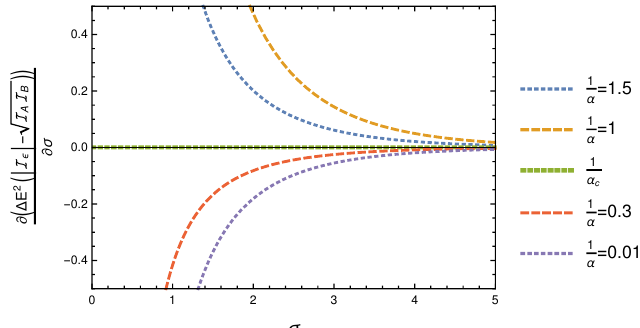
Figure 8 . In (1 + 1) dimensions the quantity ( ∂/∂σ ) anti-parallelly accelerating detectors with respect to the equal magnitude of proper accelerations α A = α B for fixed inverse temperature of the thermal bath σ . The critical acceleration, where this quantity is σ independent, is α